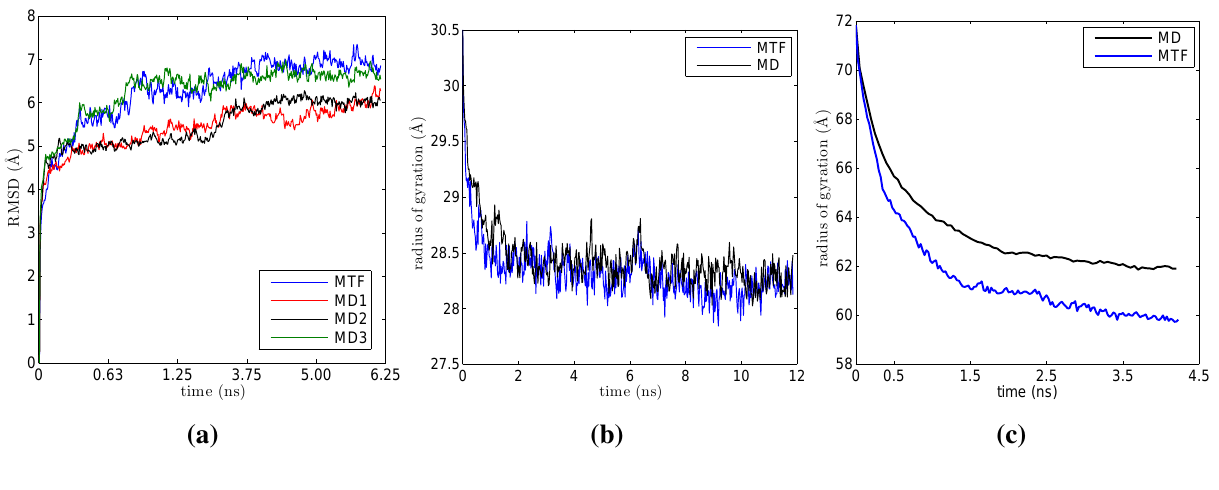
Figure 5. MD and multiscale factorization (MTF) results for lactoferrin and N ω v simulations. ( a ) RMSD variation of lactoferrin as a function of time for a series of three MD and one MTF runs; ( b ) the radius of gyration decreases in time as lactoferrin shrinks; ( c ) temporal evolution of the radius of gyration of N ω v computed using MD and MTF.